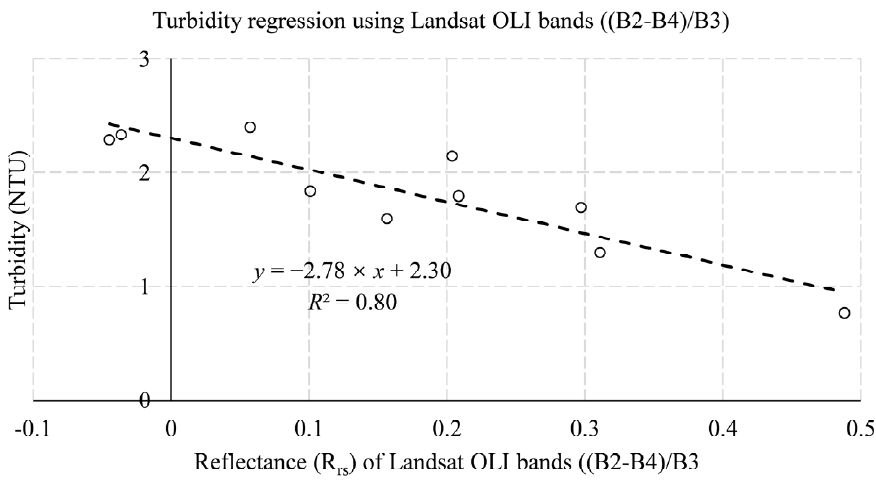
Figure 7. In situ-derived turbidity and Landsat OLI bands reflectance from training datasets.